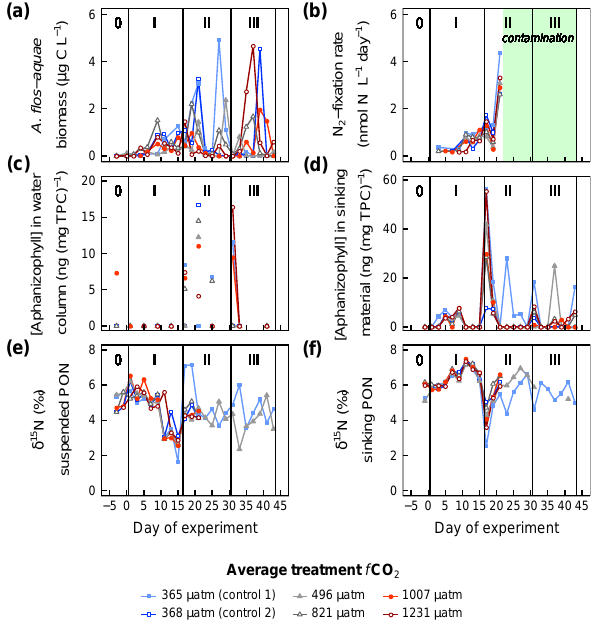
Figure 3. Variables indicating abundance and activity of filamen- tous diazotrophic cyanobacteria: (a) biomass of A. flos-aquae calcu- lated from microscopy abundance data, (b) N 2 -fixation rates deter- mined by stable isotope incubations, (c) carbon-normalised Aphani- zophyll marker pigment concentration (>20µm) relative as a proxy for A. flos-aquae abundance in the water column and (d) in the sed- iment trap material, (e) natural abundance δ 15 N of particulate or- ganic nitrogen (PON) in the water column and (f) natural abundance δ 15 N in the sinking particle organic nitrogen collected in the sed- iment trap determined by analyses on an isotope ratio mass spec- trometer. The green shaded area in (b) between t23 and t43 indi- cates when contaminated 15 N-N 2 gas was used in incubations (see Dabundo et al.,